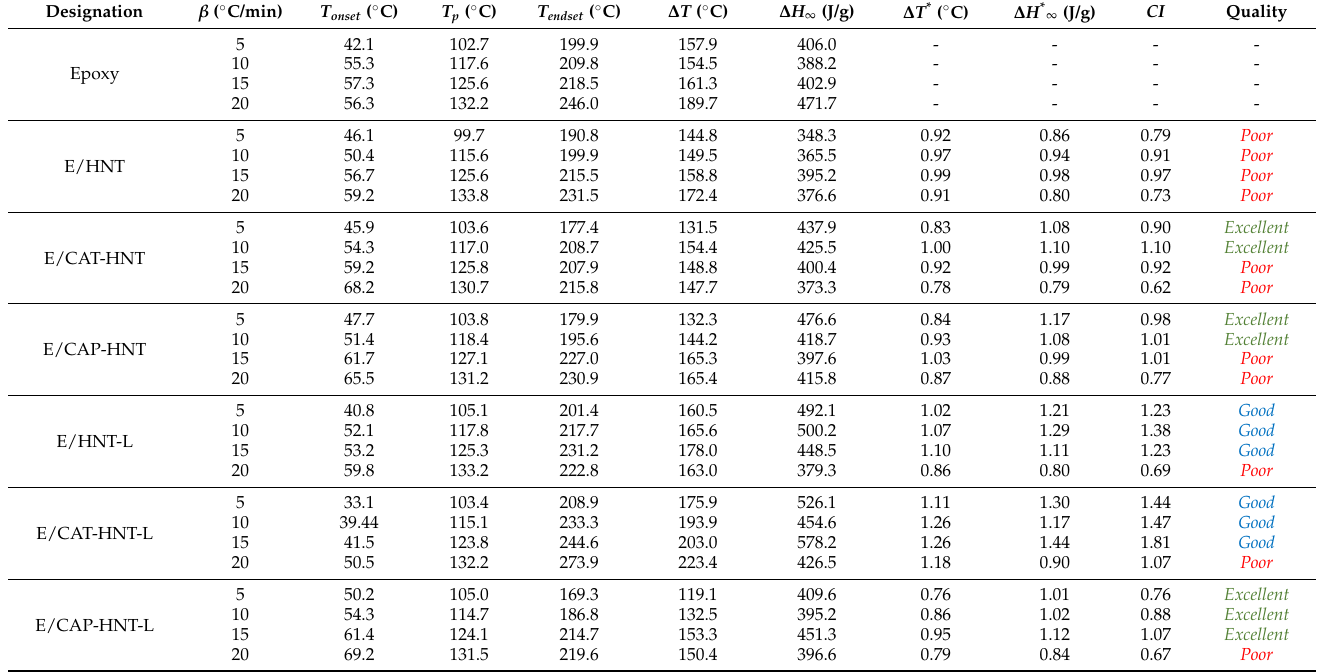
Table 1. Cure characteristics of epoxy and its nanocomposites as a function of heating rate ( β